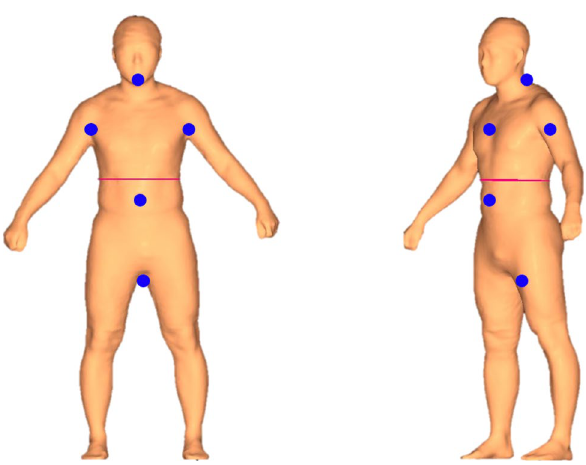
Figure 3. Sample of the 3D mesh data and standard landmarks for measurement.